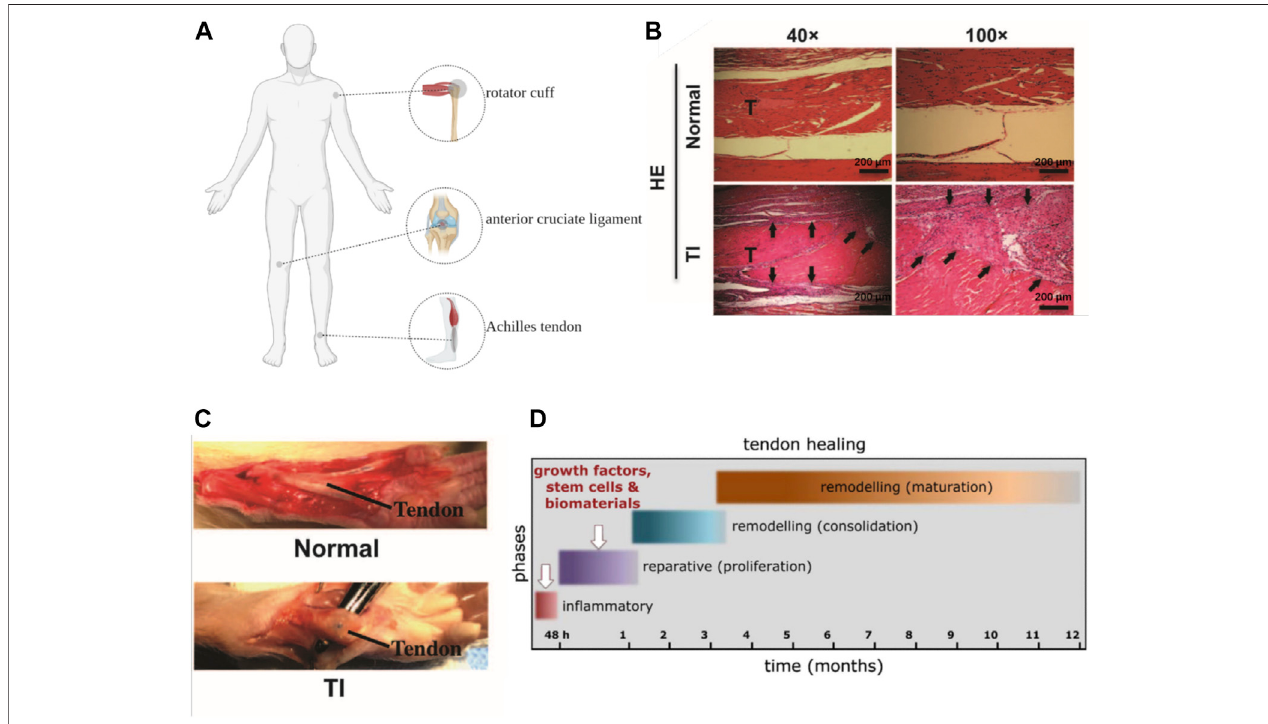
FIGURE 2 | (A) : Anatomical position of Achilles tendon, rotator cuff and anterior cruciate ligament (Created with BioRender.com). (B, C) : General view and HE staining of tendon injury (TI) (scar and adhesion) and normal control (Chen et al., 2017). (D) : the process of tendon repair (Docheva et al., 2015).